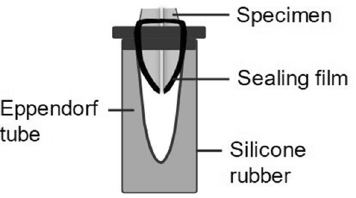
Figure 2. Schematic presentation of the apparatus for collecting apically extruded